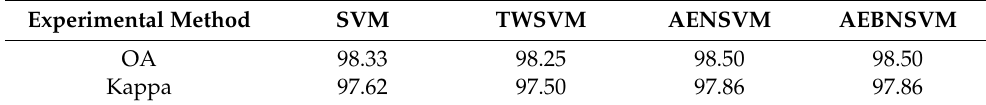
Table 4. Classification results of Pavia Center hyperspectral images.